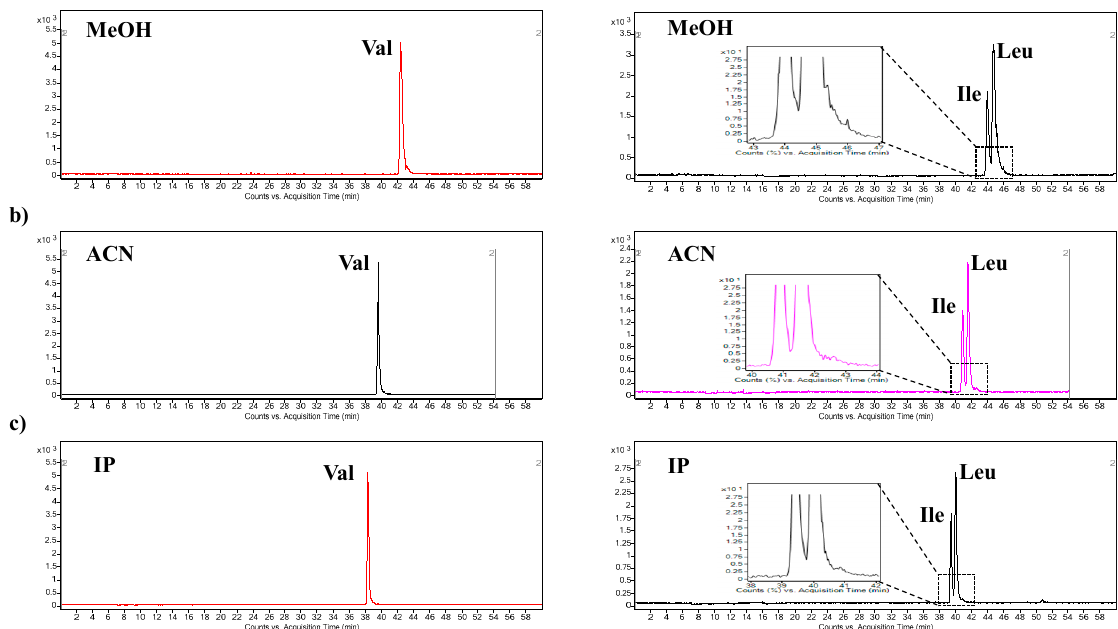
Figure 3. Optimization of the protein precipitation procedure for plasma samples. ( a ) Extracted MRM records of Val (left trace) and Ile and Leu (right trace), obtained after the plasma sample precipitation procedure with methanol (MeOH). ( b ) Extracted MRM records of Val (left trace) and Ile and Leu (right trace), obtained after the plasma sample precipitation procedure with acetonitrile (ACN). ( c ) Extracted MRM records of Val (left trace) and Ile and Leu (right trace), obtained after the plasma sample precipitation procedure with isopropanol (IP). For details of the capillary electrophoresis-tandem mass spectrometry method, see Section 3.